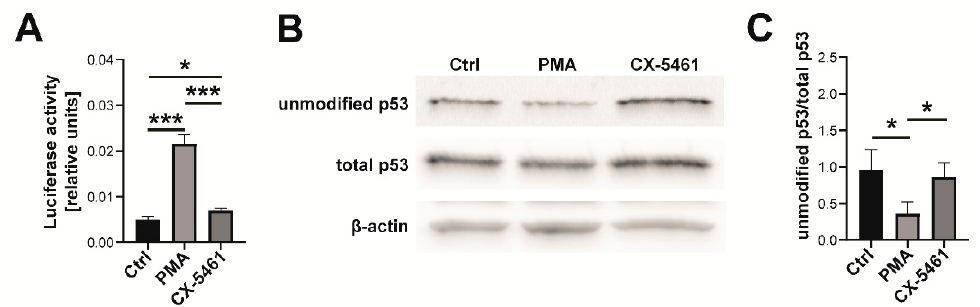
Figure 3. Influence of PMA and CX-5461 on p53 activity. ( A ) Luciferase assay performed using lysates from control (Ctrl) undifferentiated MO3.13 cells and cells treated with PMA or CX-5461. Results are presented as a ratio between Firefly and Renilla luciferase activity. ( B ) A representative Western blot showing protein level of unmodified p53, total p53, and actin (loading control). ( C ) Densitometric analysis of the level of unmodified p53. Results are presented as the ratio of unmodified to total p53, both normalized to actin. ( A , C ) Statistical analysis of results ( n = 3) was performed with the use of one sample t test. Results are presented as means ± standard error. The level of statistical significance is indicated using * p ≤ 0.05, *** p ≤ 0.001.